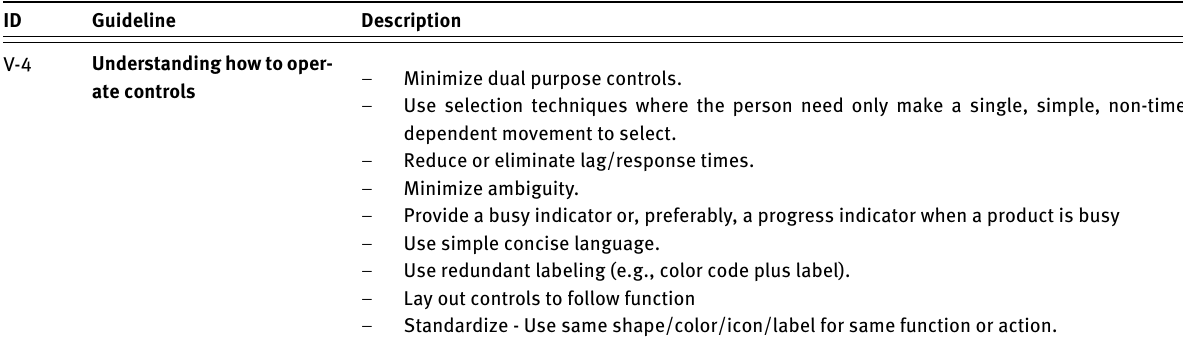
Table 13. Relevant Vanderheiden and Vanderheiden’s Guidelines for the Design of Consumer Products to Increase Their Accessibility to Persons with Disabilities or Who Are Aging [83] (Part 2 of